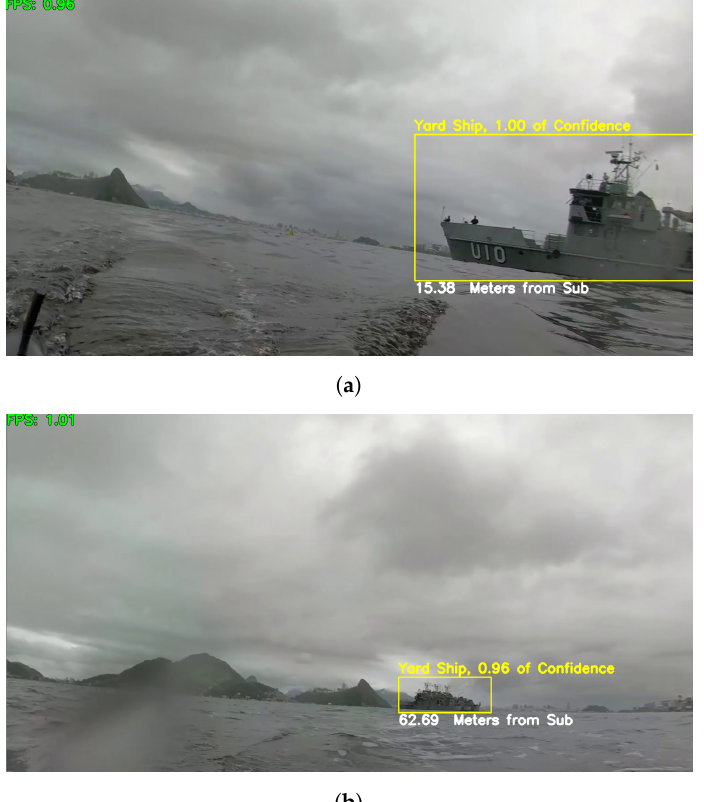
Figure 16. Results on two frames of a video sequence captured by our XR Periscope device. ( a ) Yard Ship at 15.38 m; ( b ) Yard Ship at 62.69